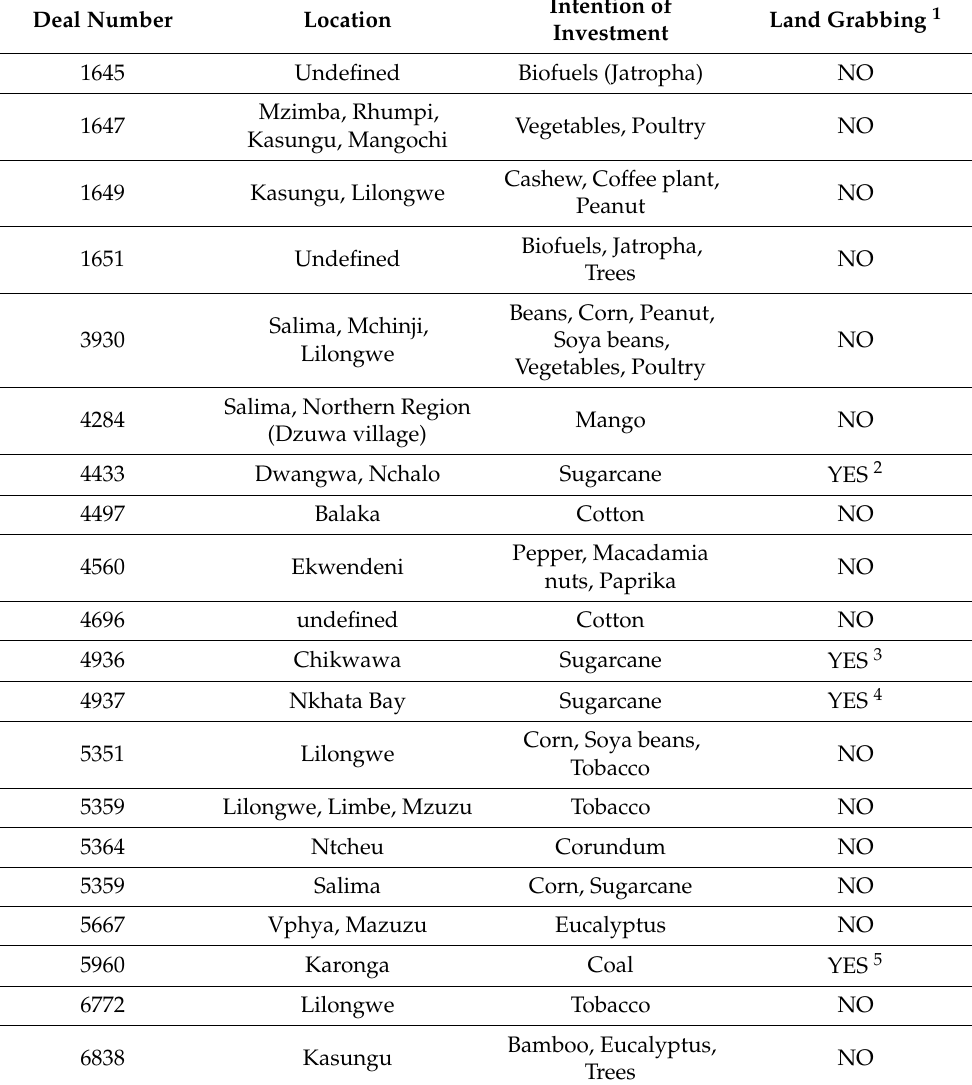
Table 1. Land deals in Malawi